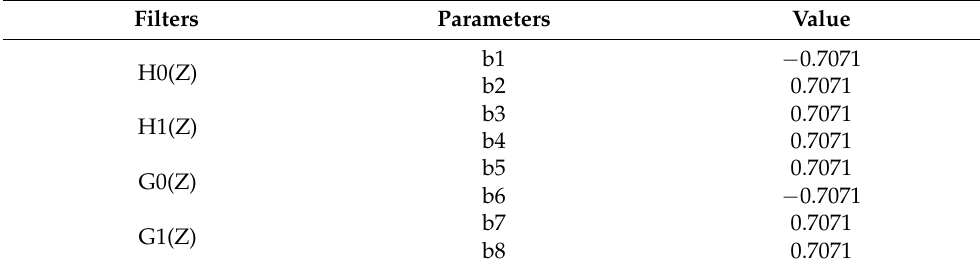
Table 1. State parameters of the two-channel quadrature filter bank. Filters